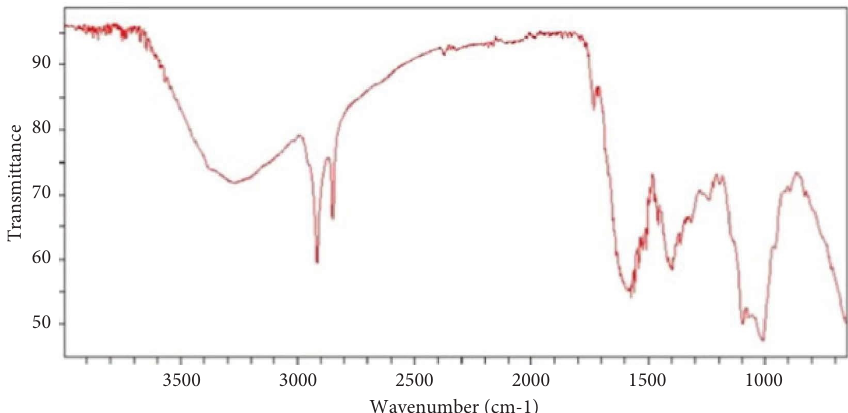
Figure 4: Representative FTIR spectrum of Trigonella foenum-graecum leaves. Table 3: Diferent extracts and biological efcacies of Zingiber ofcinale rhizome. Activities